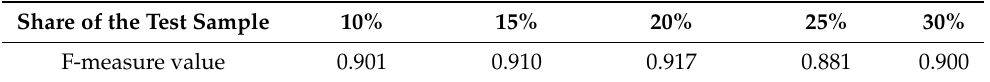
Table 5. F-measure value for different test sample sizes.